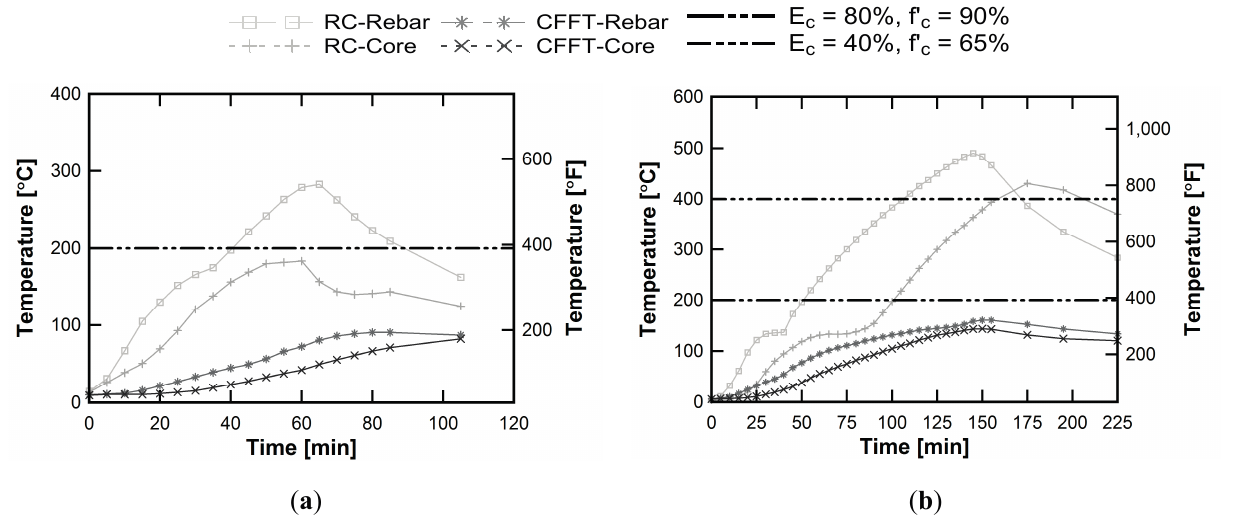
Figure 12. Interior concrete temperatures during the ( a ) 1-Hr and ( b ) 2-Hr